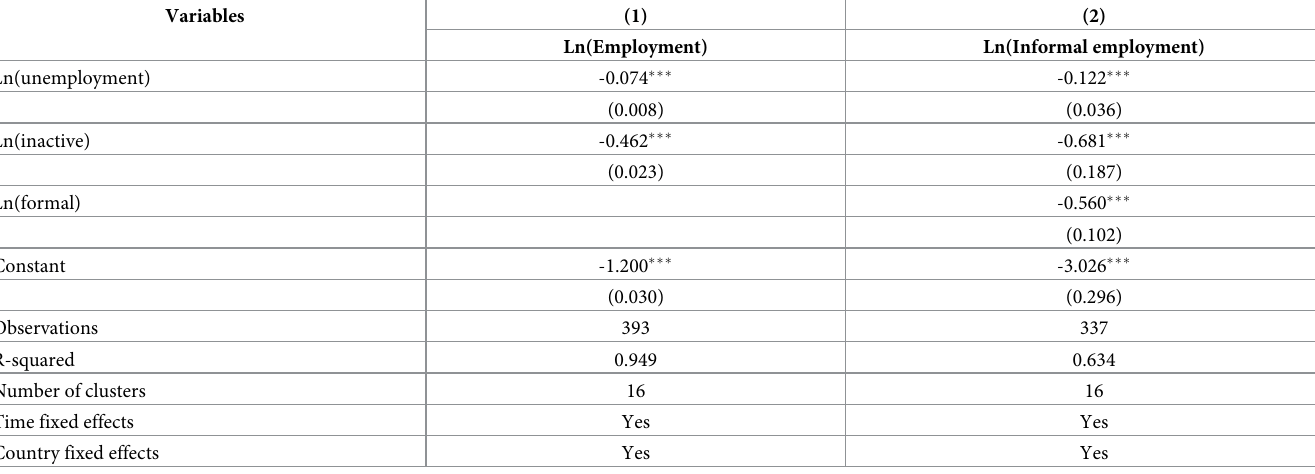
Table 7. Estimate for Latin America of the correlation between the informality rate and economic activity